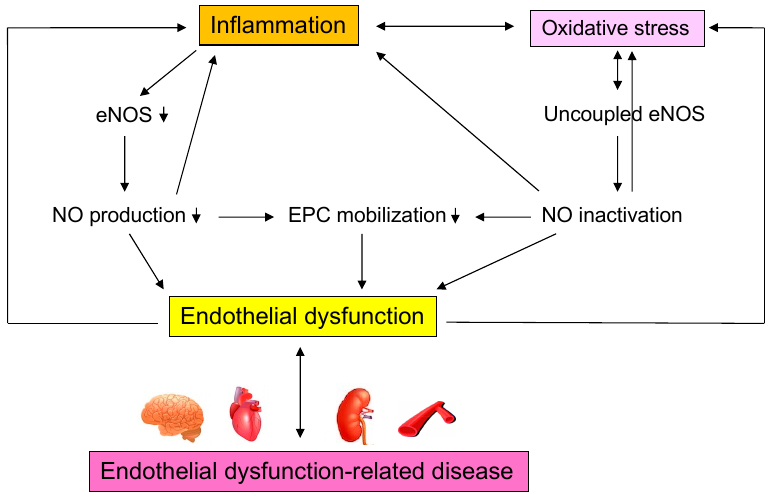
Figure 3. Mechanisms by which inflammation induce endothelial dysfunction-related disease. eNOS, endothelial nitric oxide synthase; NO, nitric oxide; EPC, endothelial progenitor cell.